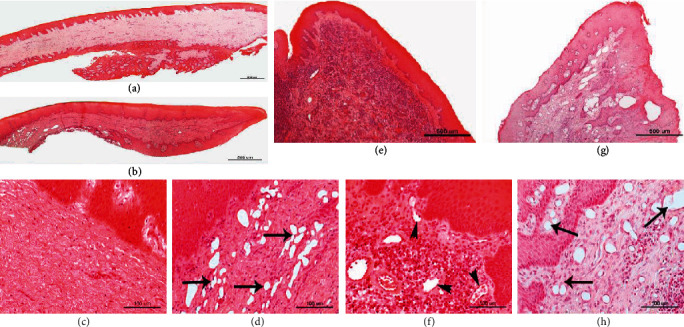
Microscopic study of the investigated human and porcine gingival tissues. (a, c) Healthy porcine gingival tissue with regular histological structure; (b, d) the investigated porcine gingival samples show cavities of irregular shape and size (arrows) in the connective tissue created after the irrigation procedures; (e, f) gingiva of periodontitis patients with prominent infiltration of inflammatory cells in the connective tissue beneath the epithelium; (g, h) irrigated gingiva of periodontitis patients shows spherical bubbles (arrows) in the connective tissue and a decreased infiltration of inflammatory cells. Arrowheads indicate blood vessels. Scale bars: (a, b, e, g) 500 μm; (c, d, f, h) 100 μm.